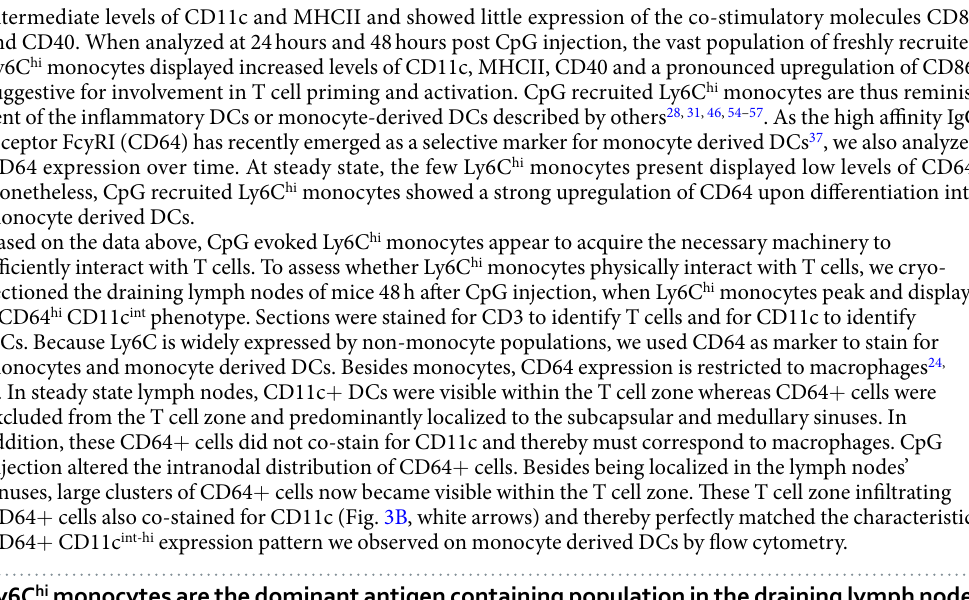
Figure 2. Flt3L − / − mice and Ccr2 − / − mice show impaired effector T cell responses. Analysis of the effector T cell response to OVA/CpG vaccination. ( A – C ) Comparison of effector T cell responses between WT and Flt3L − / − mice. ( D – F ) Comparison of effector T cell responses between WT and Ccr2 − / − mice. ( A , D ) ELISPOT analysis determining the numbers of IFN- γ secreting T cells (n = 6; mean + / − SD). ( B , E ) Flow cytometric quantification of OVA-specific CD8 T cells in blood (n = 5/group; mean + / − SD). ( C , F ) OVA-specific cytotoxicity as measured by an in vivo killing assay (n = 7/group; mean + / − SD). **** P < 0.0001, *** p < 0.001. Data shown are representative of three independent